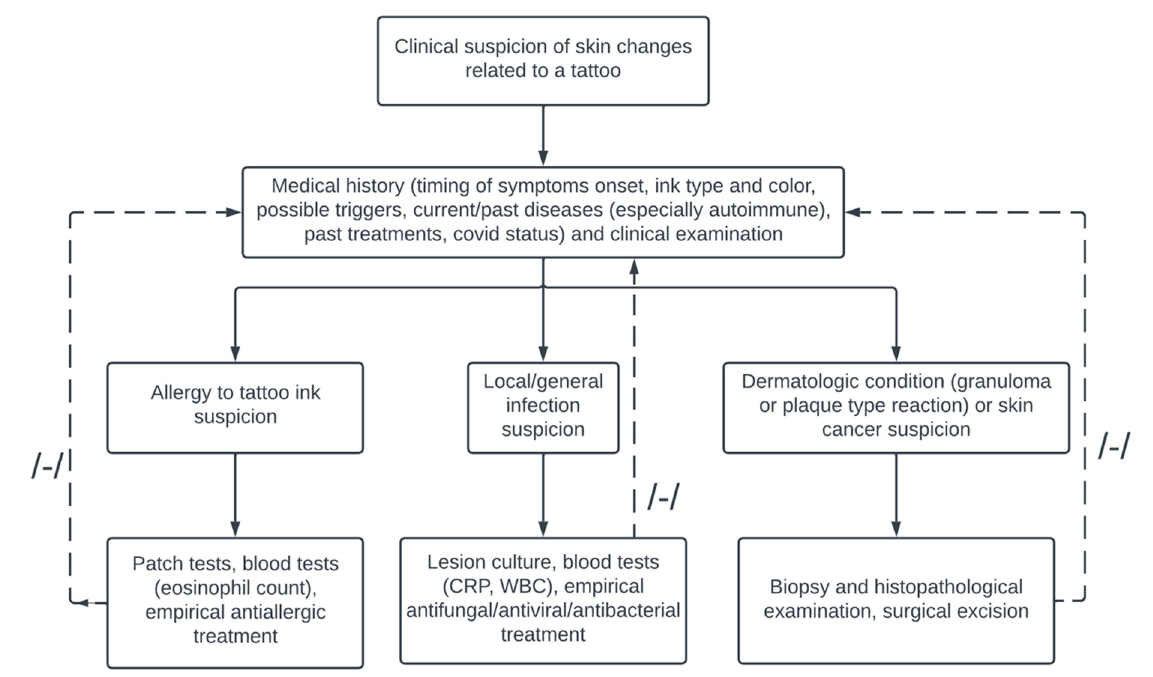
Figure 5. Diagnostic algorithm in case of lesions suspected of being related to a tattoo.